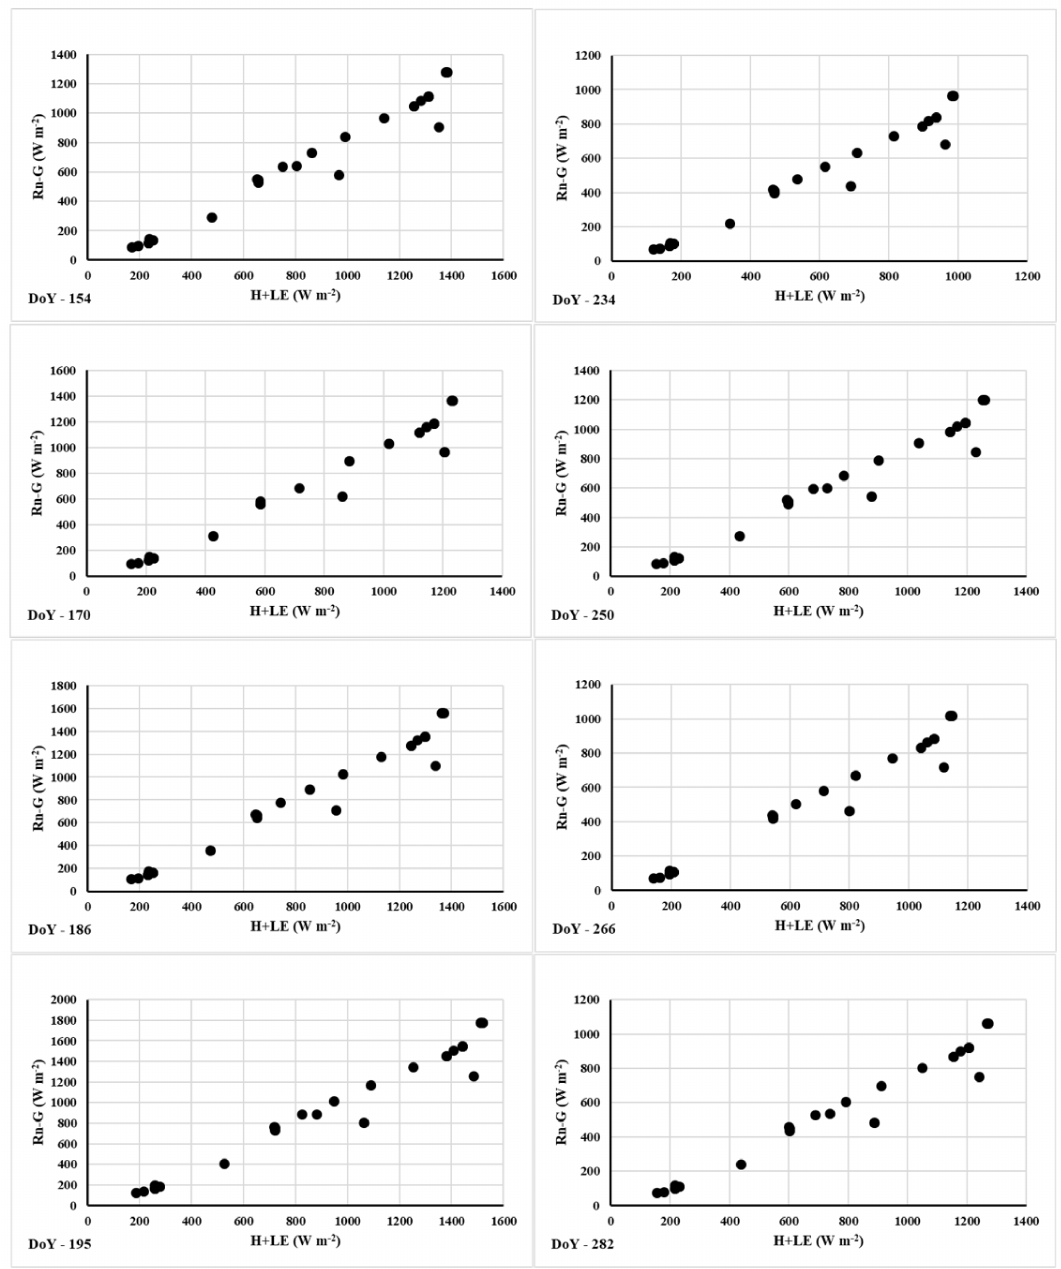
Figure 3. Energy balance (EB) closure of corrected eddy covariance (EC) data for the studied Landsat-8 date of overpass.